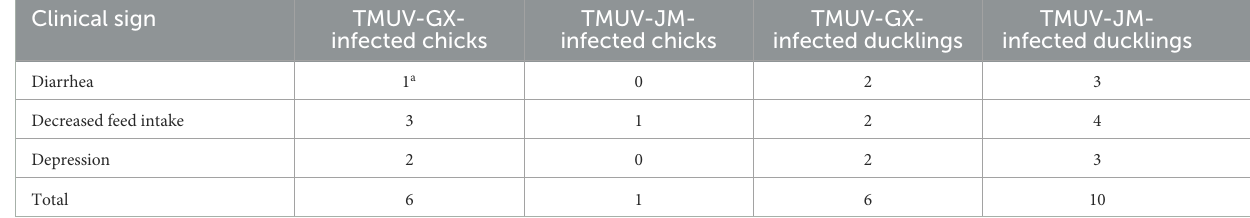
TABLE 2 Clinical signs in birds experimentally infected by TMUV. Clinical sign